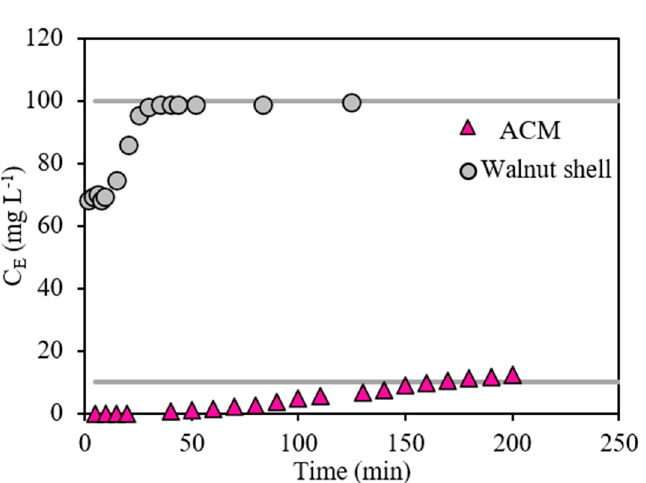
Figure 11. Breakthrough curves for the walnut shell (WH) and activated carbon modified with 5.0 wt.% of magnetite nanoparticles (ACM), at room temperature conditions and with an initial concentration of 100 mg L − 1 of crude oil in water.